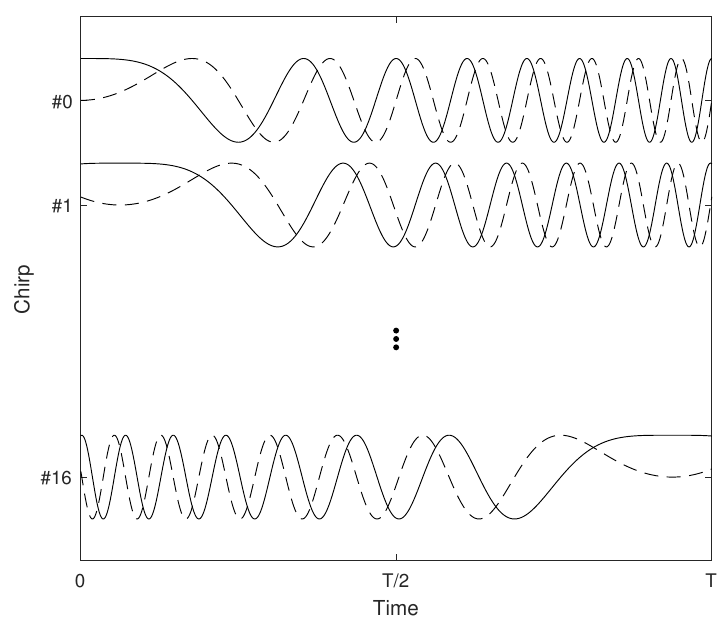
Figure 1. OCDM chirp waveforms for N =